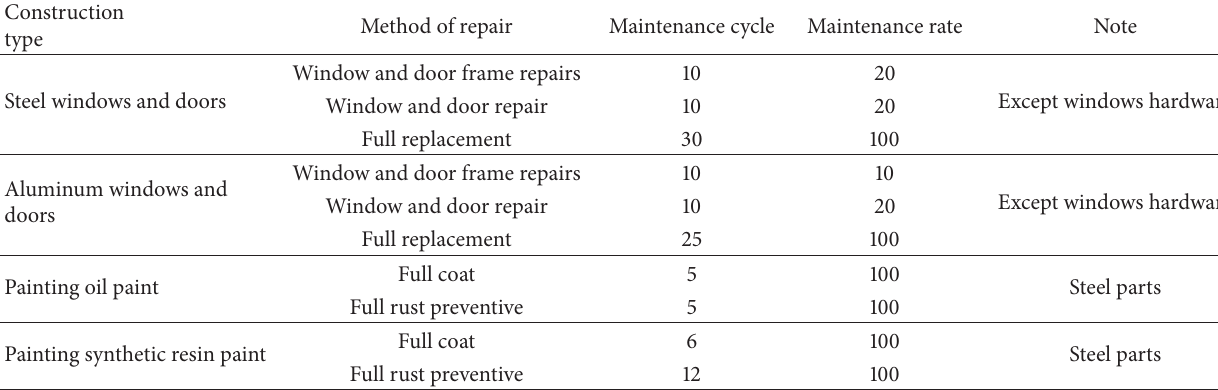
Table 4: Repair and replacement cost of windows.